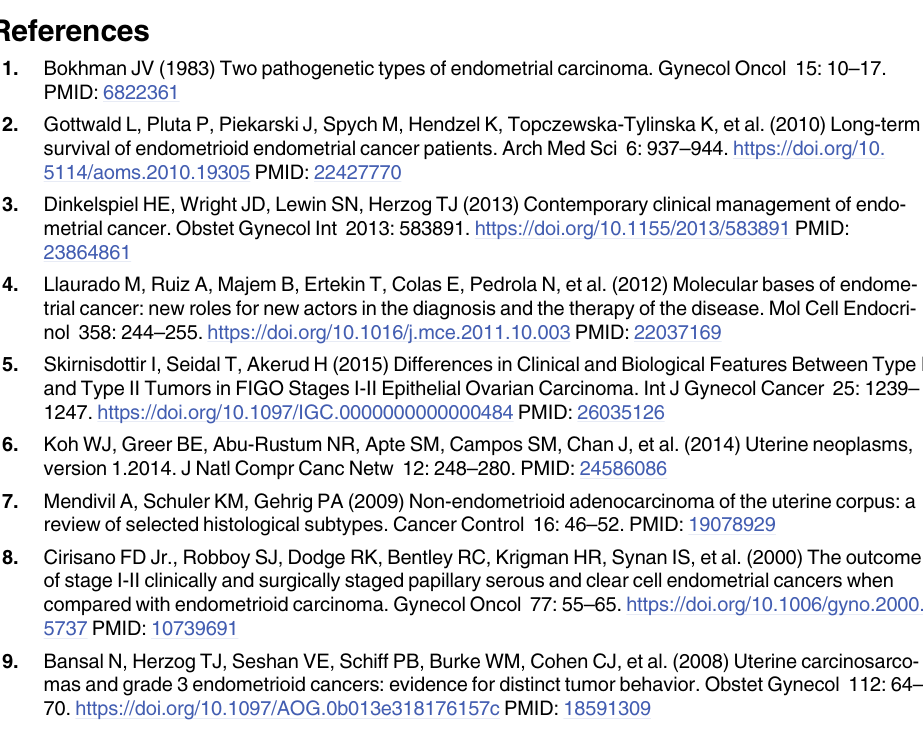
S1 Fig. Primary data of parts of patients with type II